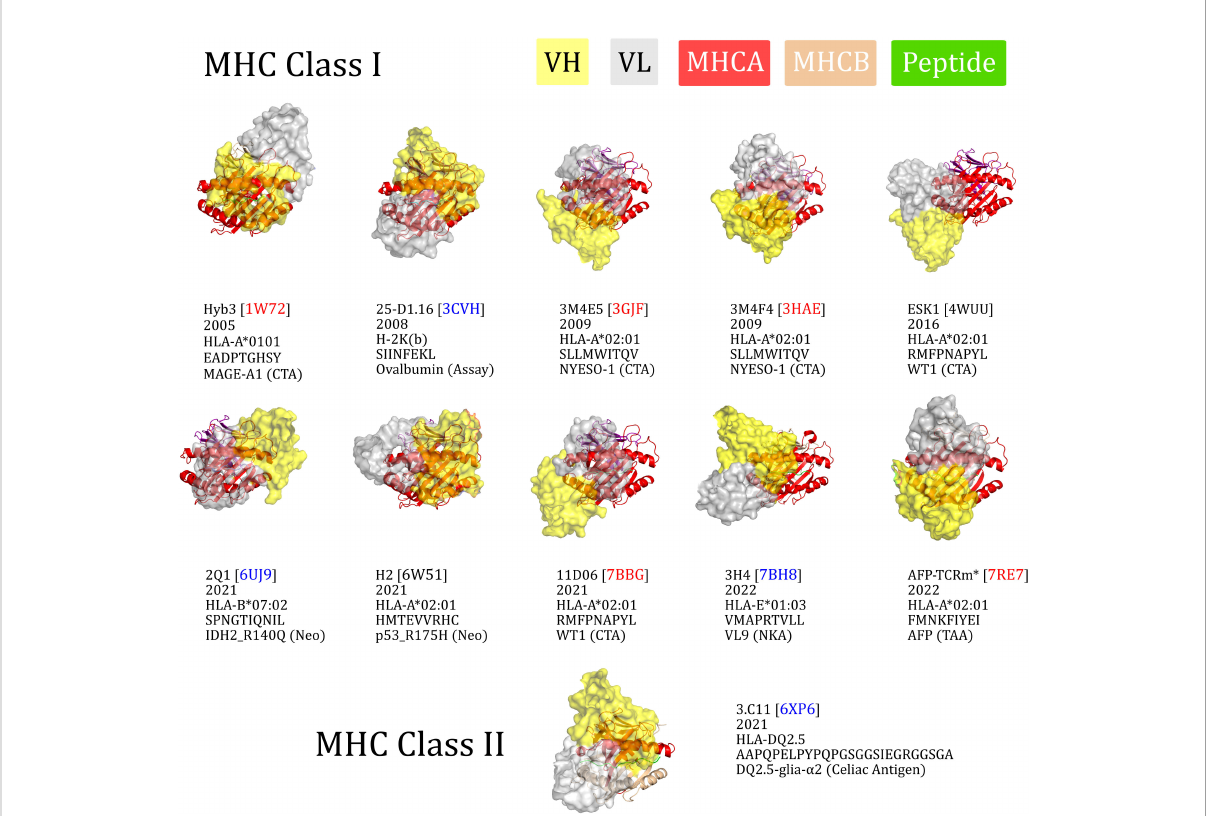
FIGURE 2 The eleven TCR-mimetic antibodies (TCRms) with solved structures in complex with their cognate pMHC, aligned by the MHC residues. The perspective is set so that the x-axis is the vector through the C a atoms of the peptide anchor residues. 3M4E5 and 3M4F4 are closely related and derive from the same screening campaign, so are jointly represented by 3M4E5 in the analysis. Metadata is supplied below each structure: the TCRm name and Protein Data Bank (PDB) identi fi er, year of release in the PDB, MHC allele, antigen amino acid sequence, and antigen common name. ESK1 and H2 fall outside the range of diagonality seen in TCR:pMHC binding (PDB codes written in black). Diagonally-binding TCRms with VH in the position of VB and VL in the position of VA (canonical polarity binders) have blue PDB codes, while those with VH in the position of VA and VL in the position of VB (reverse polarity binders) have red PDB codes. CTA, cancer testis antigen; MHCA, MHC alpha chain; MHCB, MHC beta chain; Neo, neoantigen; NKA, natural killer cell antigen; TAA, tumor-associated antigen. *We have labelled the TCRm